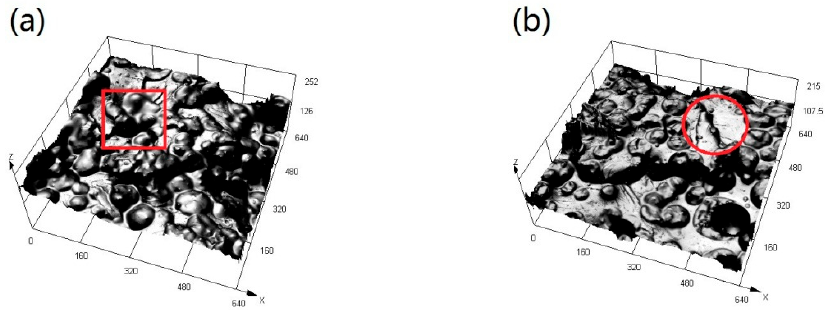
Figure 7. Fracture morphology of the ES-50 tensile specimen: ( a ) upper area and ( b ) lower area.